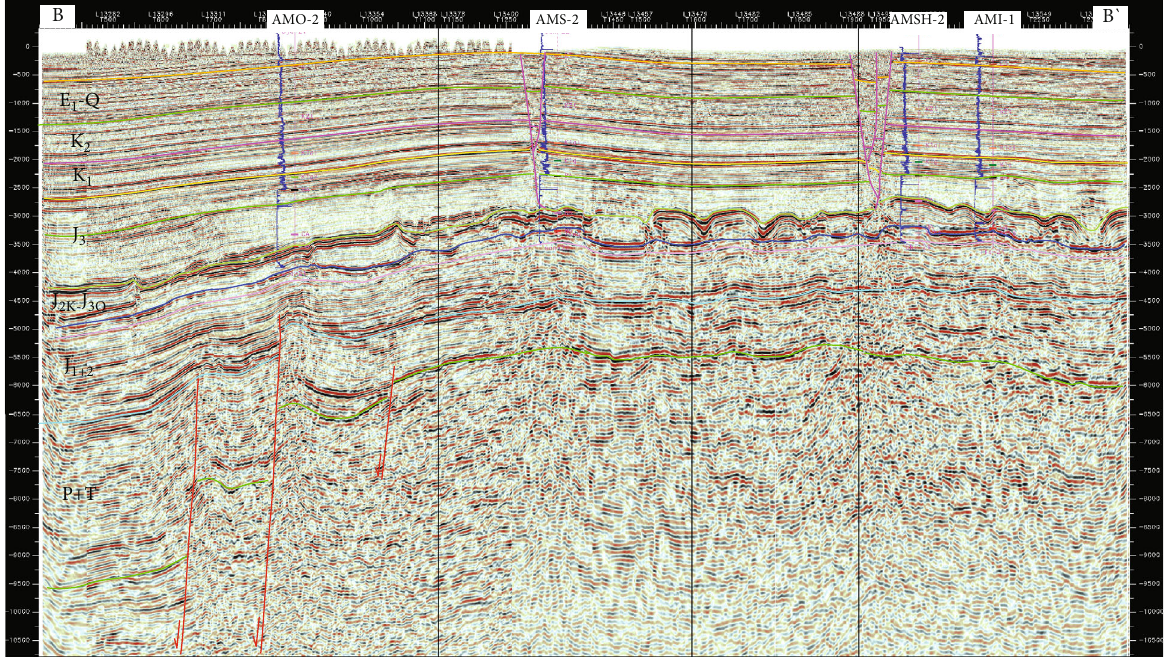
Figure 11: Seismic pro fi le of Sandykly uplift in the Amu Darya Right Bank